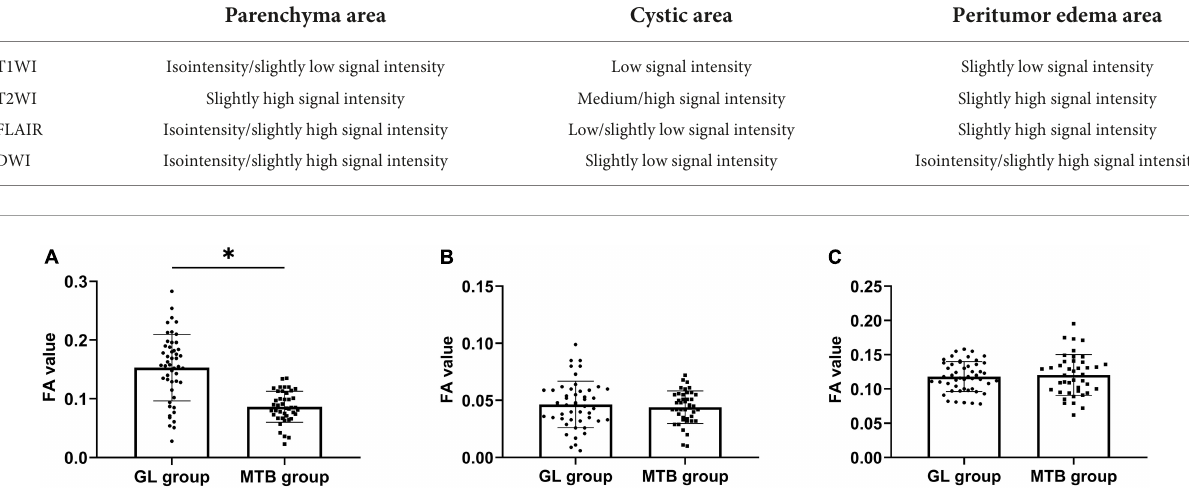
FIGURE3 Comparison of FA values between patients with GL and MTB. (A) Comparison of FA values of the tumor parenchyma area. (B) Comparison of FA values of the tumor cystic area. (C) Comparison of FA values of the peritumor edema area, * P < 0.05.